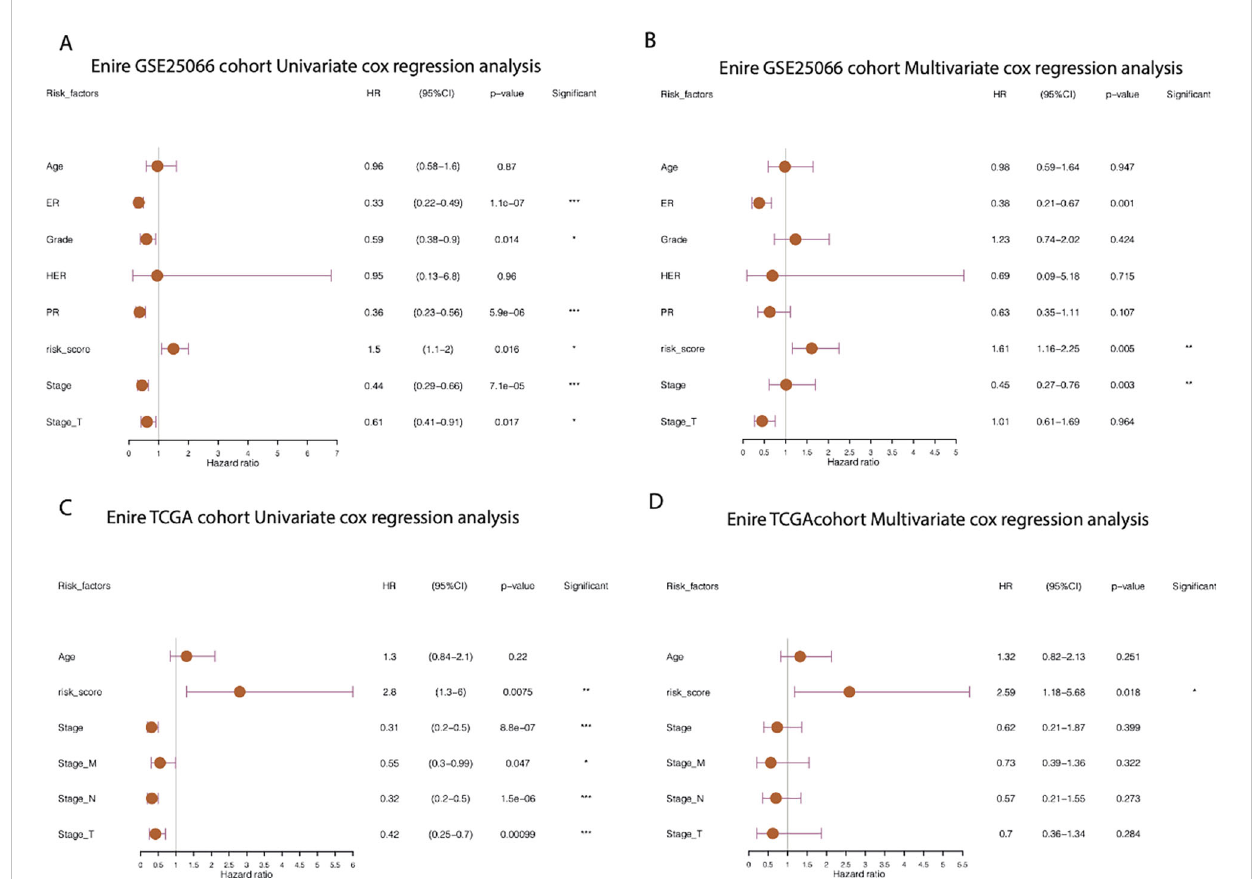
FIGURE 9 Prognostic independence analysis of cr-TILCD8TSig scoring models. Values were considered statistically signi fi cant at p<0.05 (*, p<0.05; **, p<0.01; ***, p<0.001).